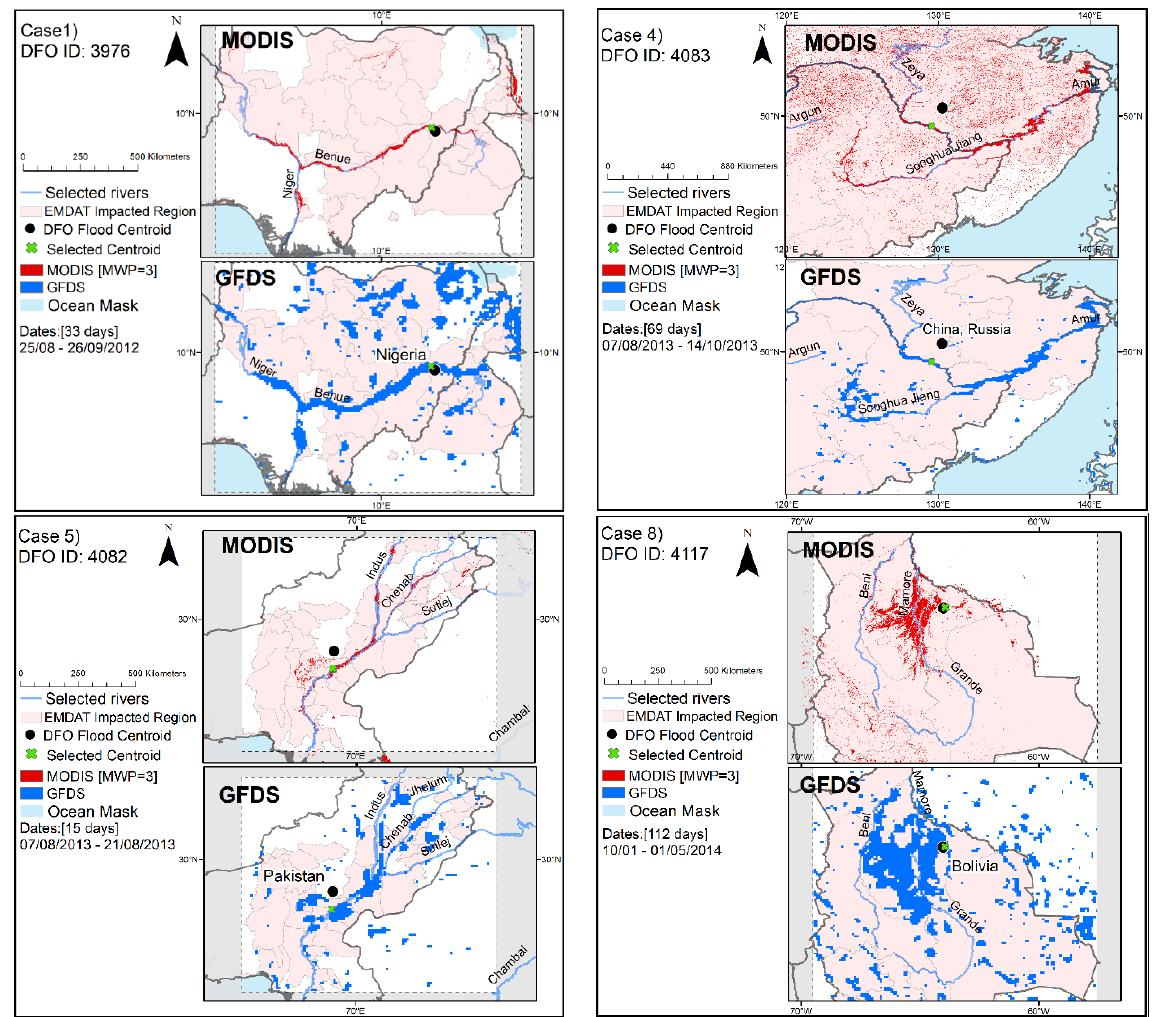
Figure 2. Maximum flood extent aggregated over the duration of a flood event as detected by GFDS (GFDS > 4) and MODIS Flood Map (MWP = 3). The flood cases shown are